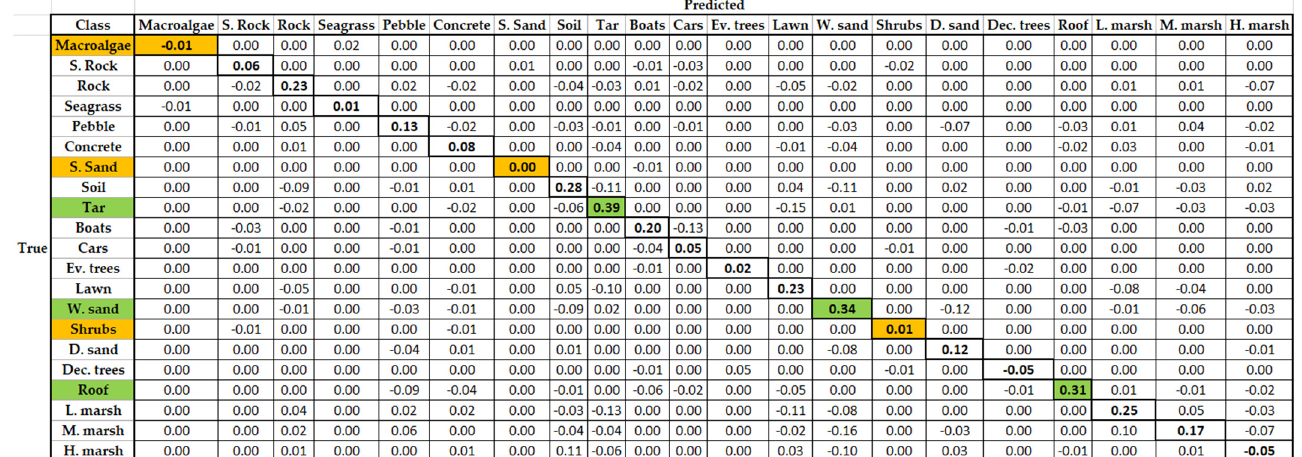
Figure A5. Difference of the confusion matrixes obtained for the classification of green waveforms’ features plus infrared intensities, and green waveforms’ features only. The three highest and three lowest class accuracy values are highlighted in green and orange, respectively. S. = submerged, Ev. = evergreen, Dec. = deciduous.